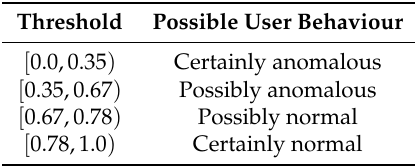
Table 7. Certainty classes defined for the threshold